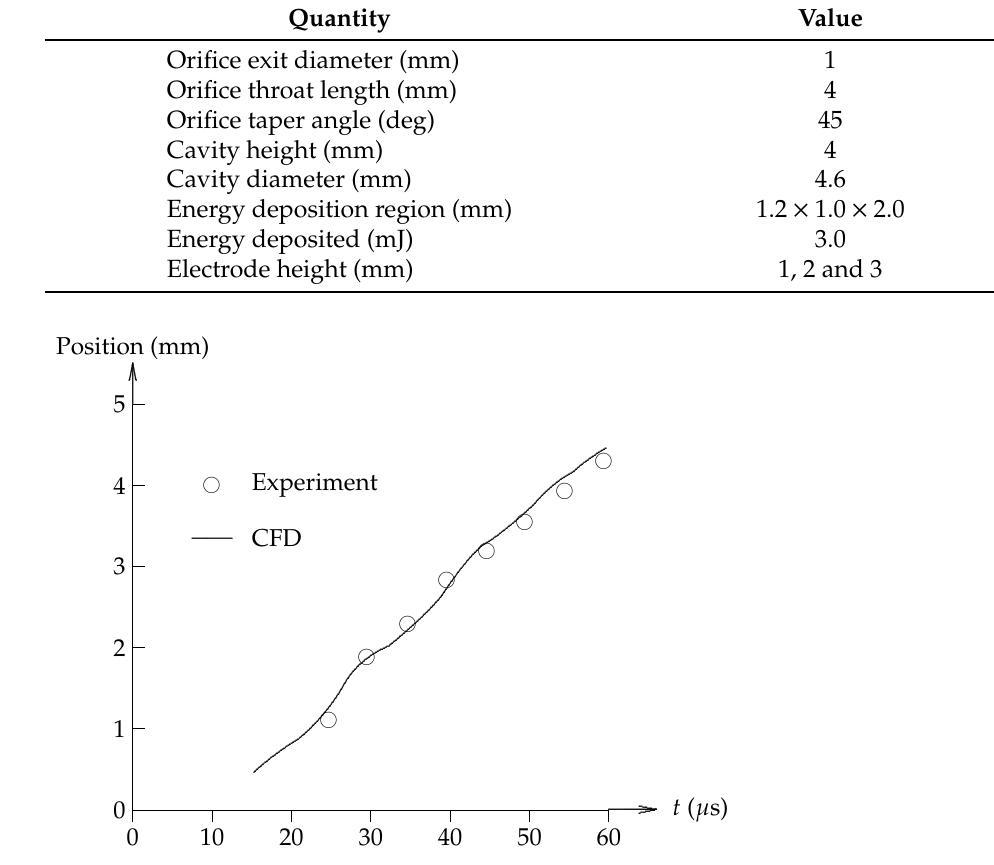
Figure 21. Jet position versus time.